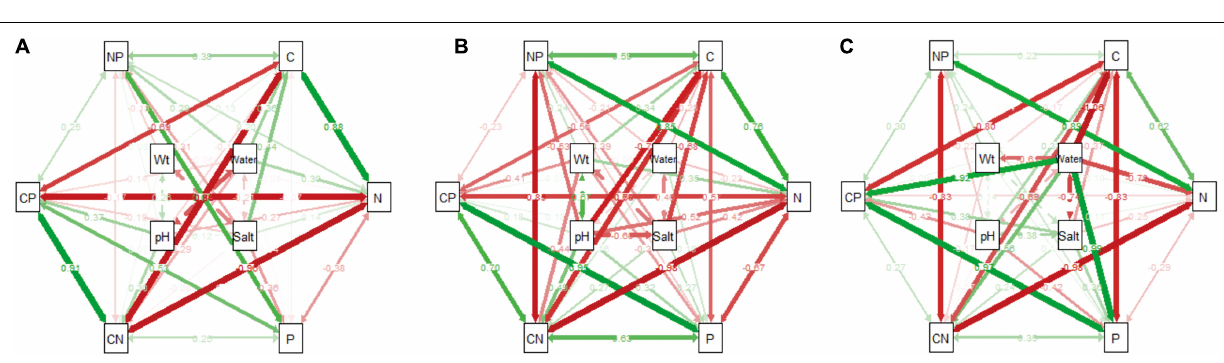
from harsh external environmental conditions (Cai et al.,